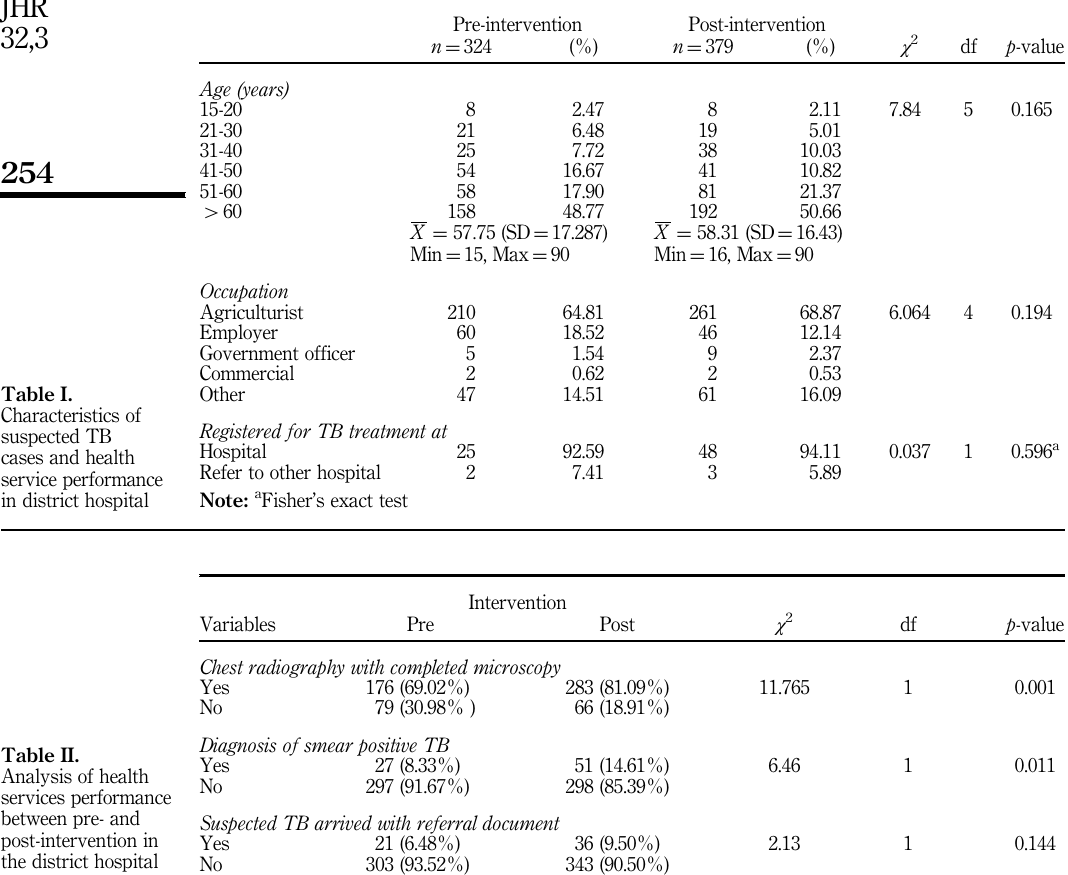
Table II. Analysis of health services performance between pre- and post-intervention in the district